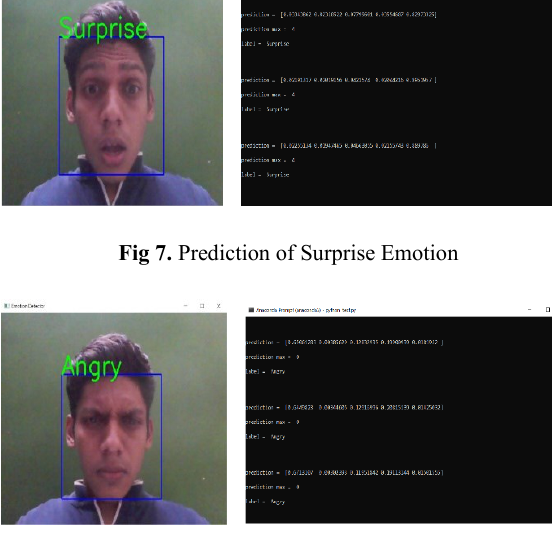
Fig 8. Prediction of Angry Emotion